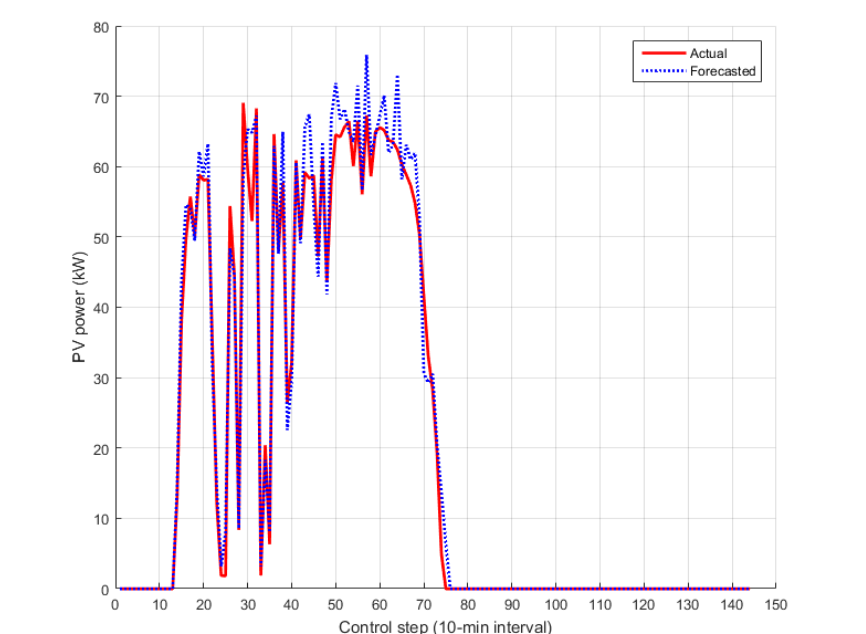
Figure 4. Actual and predicted solar